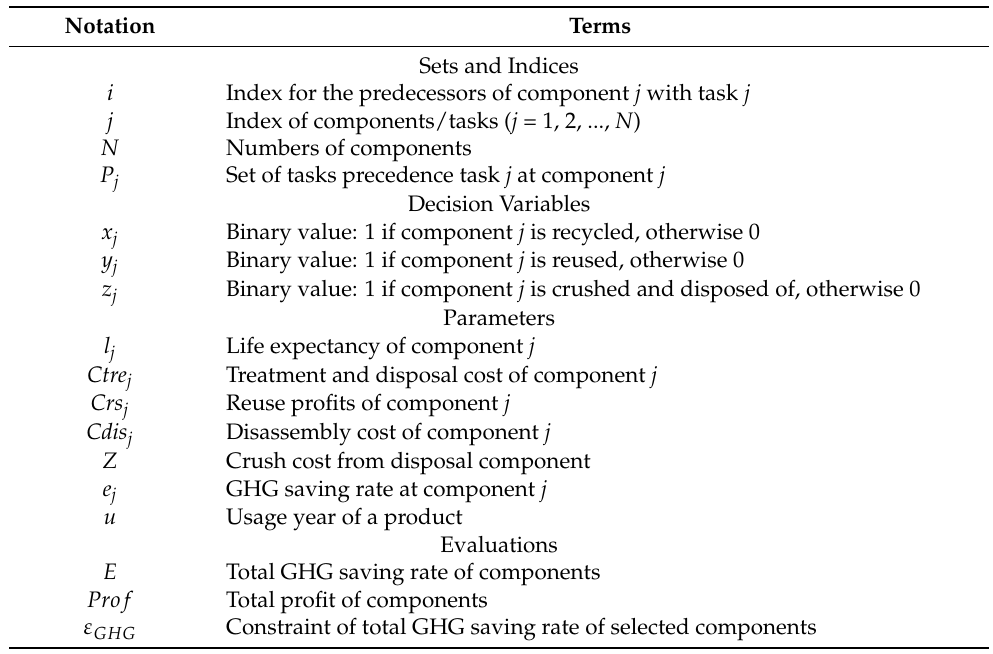
Table 2. Notation of parameters and variables used in this